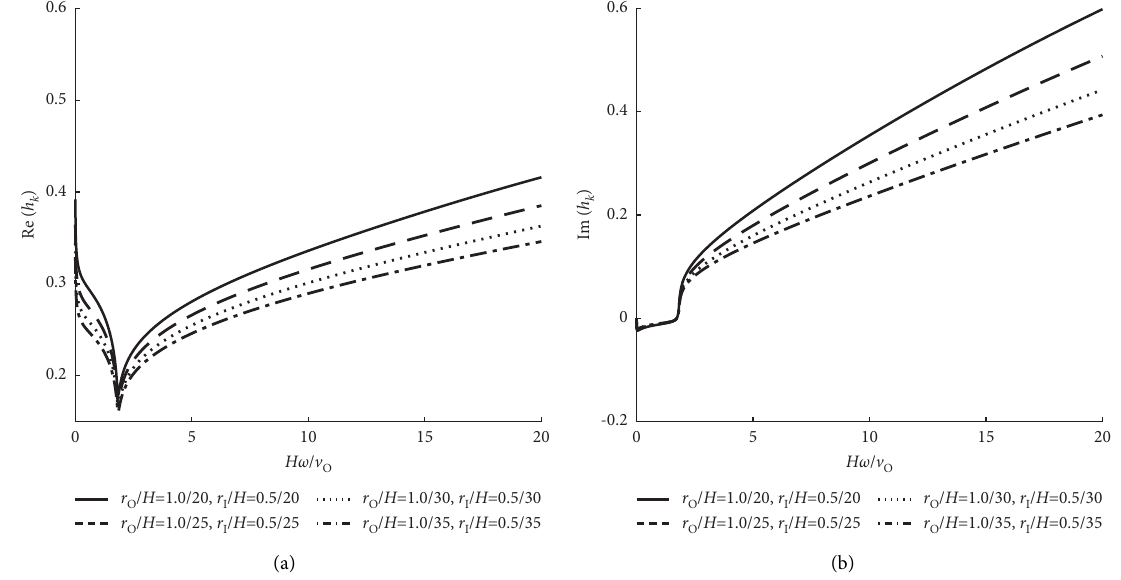
Figure 10: The impedance factor curves of soil layers under different lengths of pipe pile. (a) Horizontal stiffness factor of the soil layer. (b) Horizontal damping factor of the soil